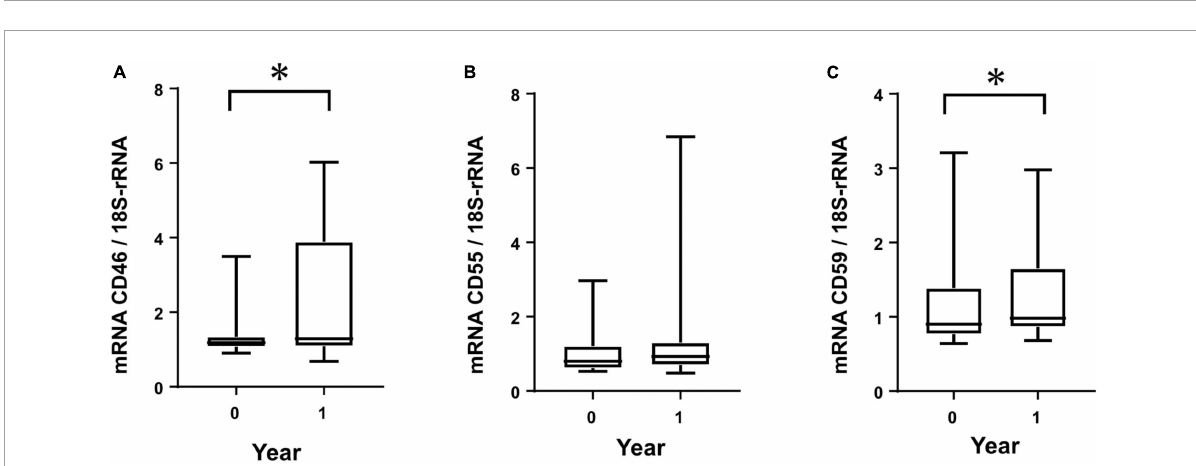
FIGURE3 Membrane complement regulator (CReg) mRNA from human peritoneal mesothelial cells of PD patients during 1 year. Clear increases were seen for mRNA of CD46 (A) and CD59 (C) , but not CD55 (B) , during 1 year. ∗ P <